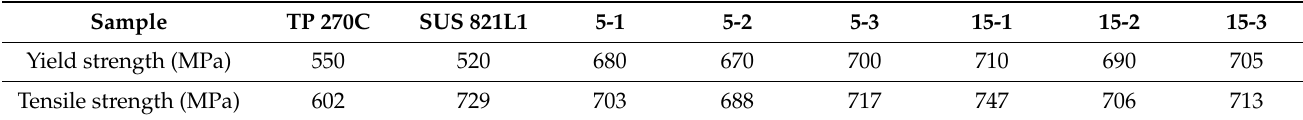
Table 1. Tensile strength of samples.